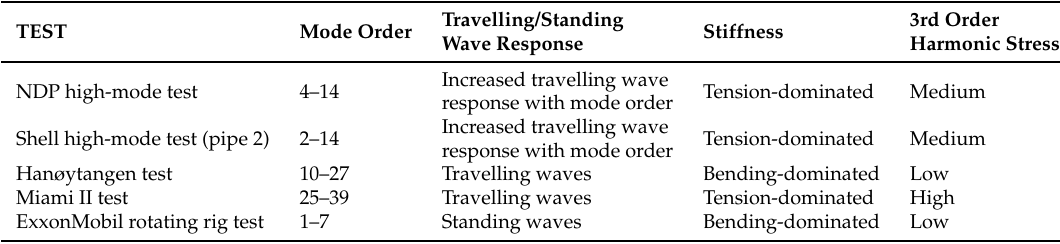
Figure 3. Bending stress ratio vs. relative bending stiffness contribution. The collective sample of experiments jointly covers a large range of parameter space, with each region being covered by more than one experiment, apart from the stress ratios and highest relative bending stiffness contributions. Table 2. Summary of response characteristics from selected model tests